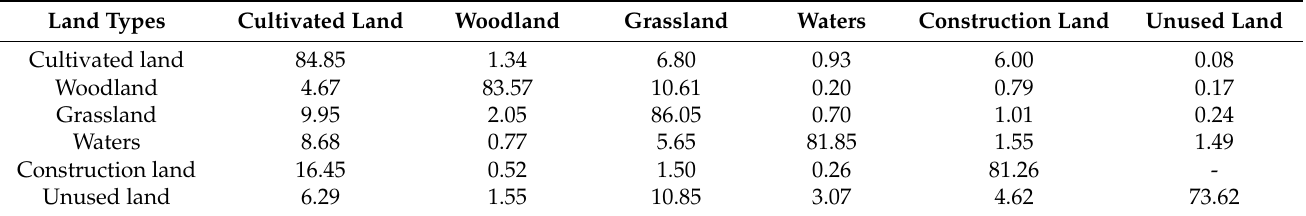
Table A2. Land-use transition probability matrix from 2010 to 2020 in the Guanzhong Plain urban agglomeration (%).